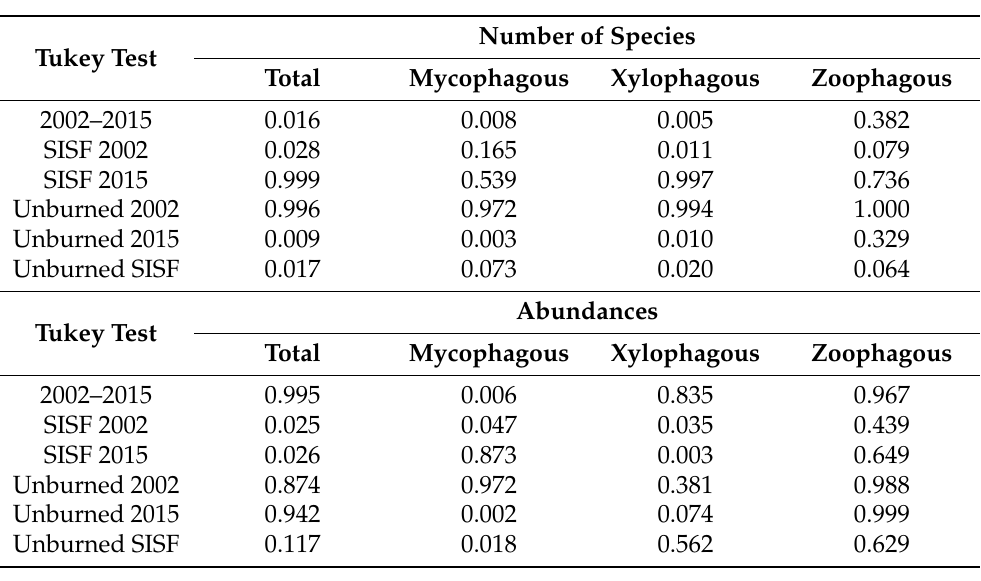
Figure 5. Box plot of the square-root-transformed number of individuals in trophic guilds in un- burned areas (plus); short-interval, severe areas (square); 2015-burned areas (triangle); 2002-burned areas (dots) of the Araucaria–Nothofagus Chilean forests. Table 3. Differences ( p -value) of the trophic guilds abundances between sampling locations using Tukey HSD tests comparisons. Bold font refers to statistically significant Tukey